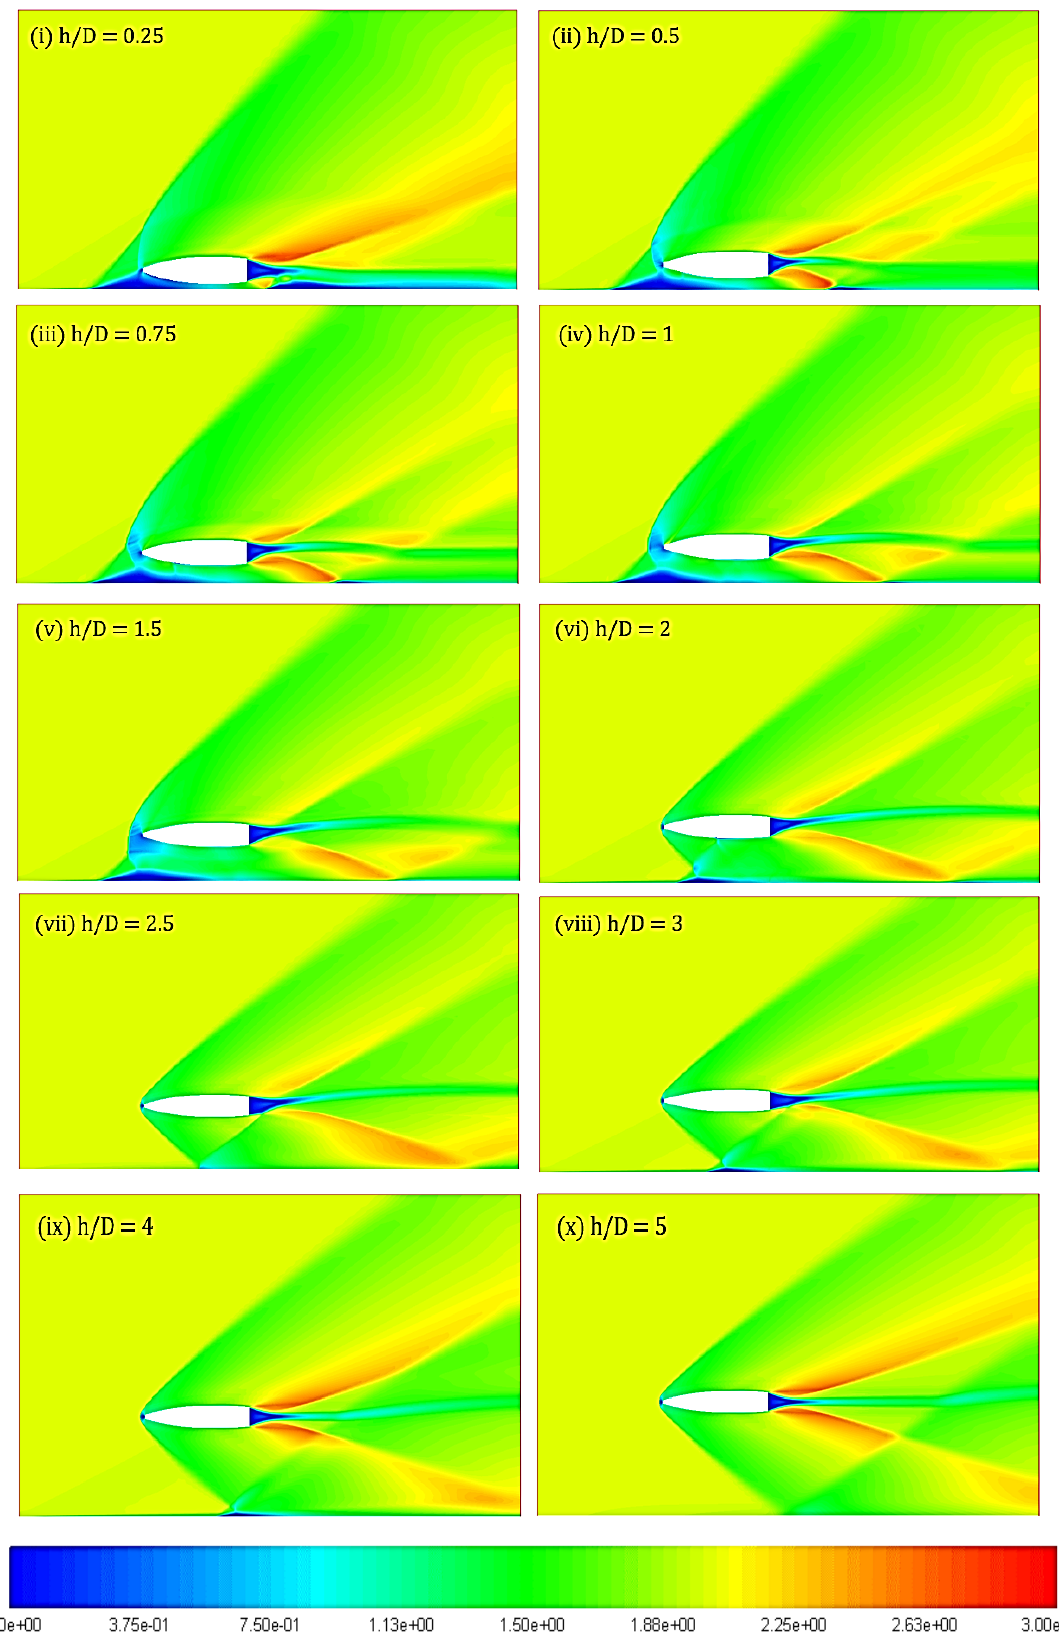
Figure 6: Mach contours for different h/D ratios starting from 0.25 to 5. The flow is from left to